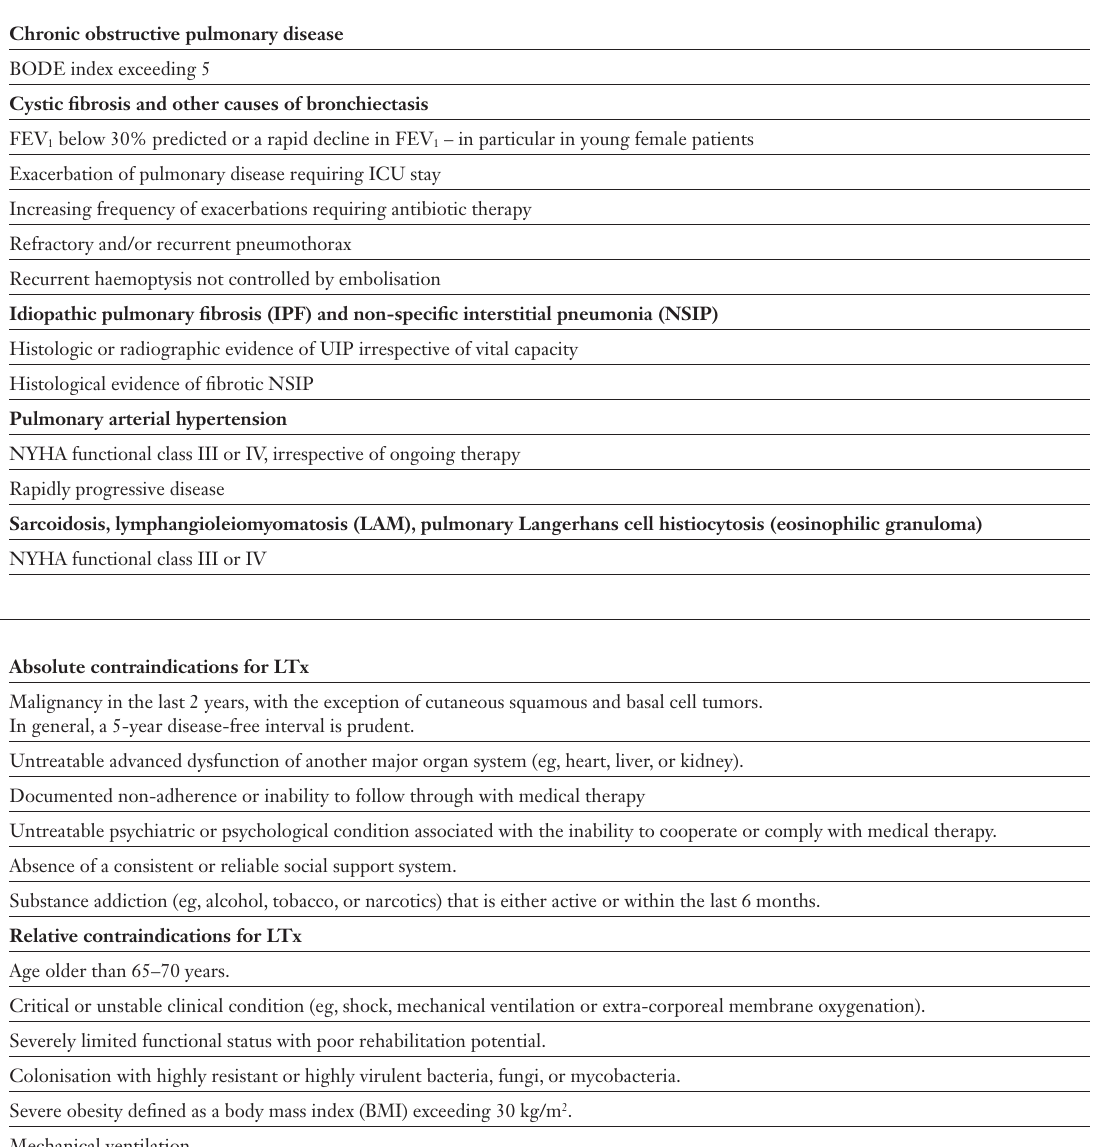
The right time for lTx-evaluation.